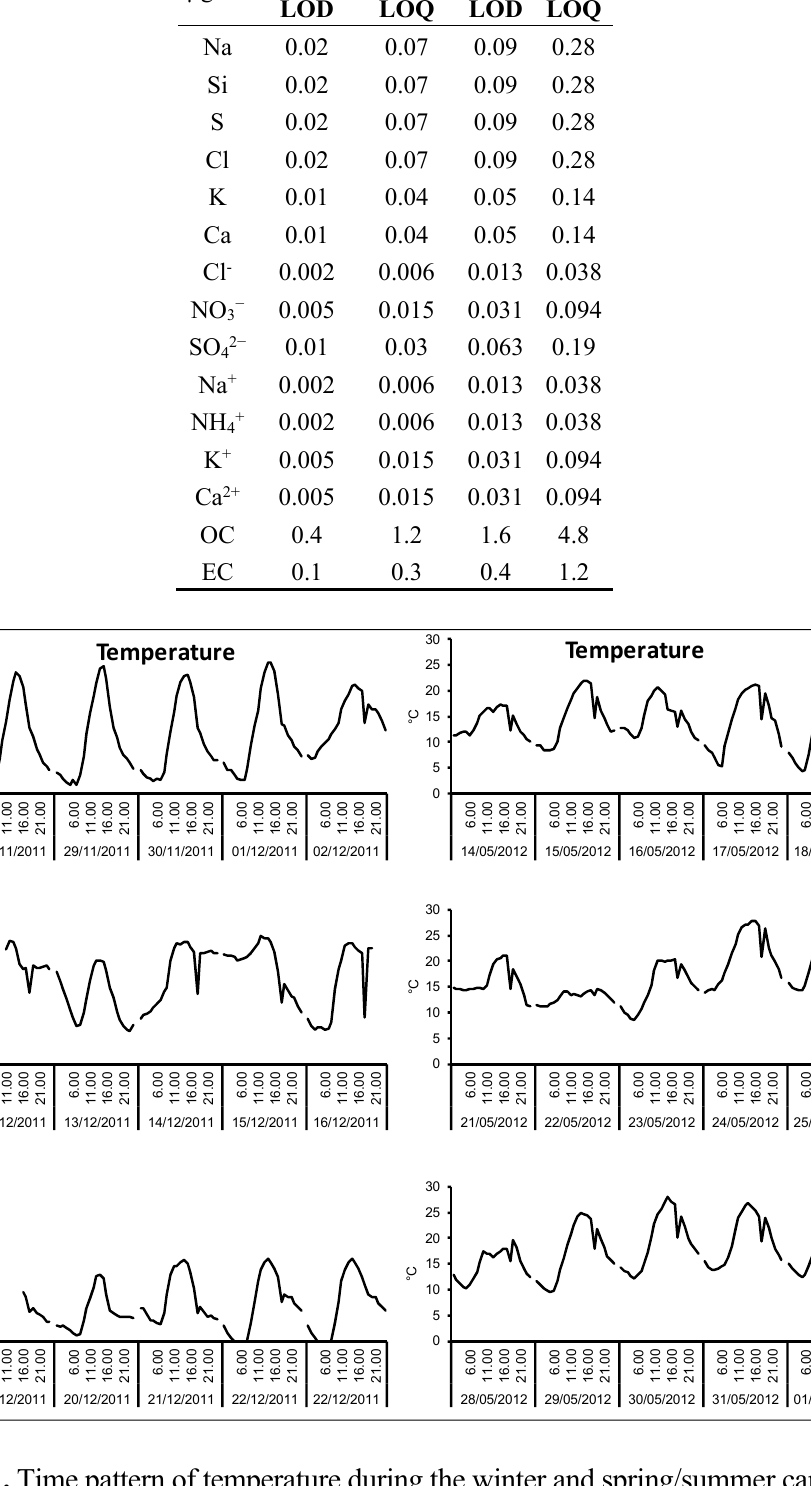
Figure A1. Time pattern of temperature during the winter and spring/summer